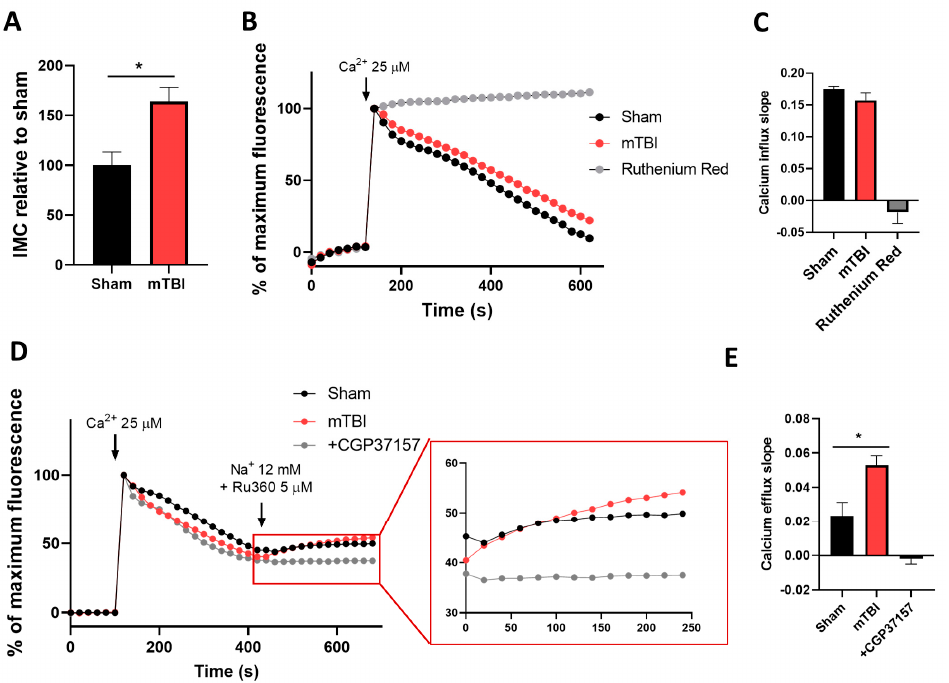
Figure 3. mTBI induces calcium overload and increased calcium efflux. ( A ) IMC relative to sham levels was measured spectrophotometrically. n = 4 for sham and 3 for mTBI. ( B ) Mitochondrial calcium uptake in isolated mitochondria measuring extramitochondrial calcium with impermeable sensor Calcium Green-5N. ( C ) Slope quantification of B. n = 4. ( D ) Mitochondrial calcium uptake and efflux measured fluorometrically as performed in B. The red square indicates the magnification of efflux curves. ( E ) Slope quantification of D. n = 3. Student’s t -test for IMC and slopes. * p < 0.05.